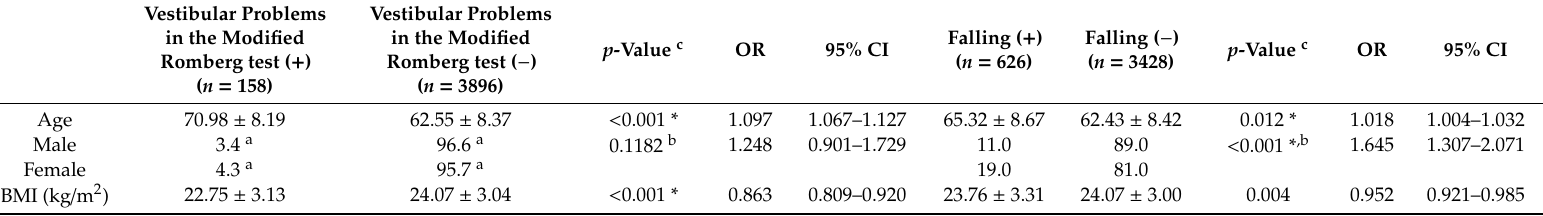
Table 1. Prevalence of falling and vestibular problems in the modified Romberg test by sex, distribution of age and body mass index BMI in each group ( n =